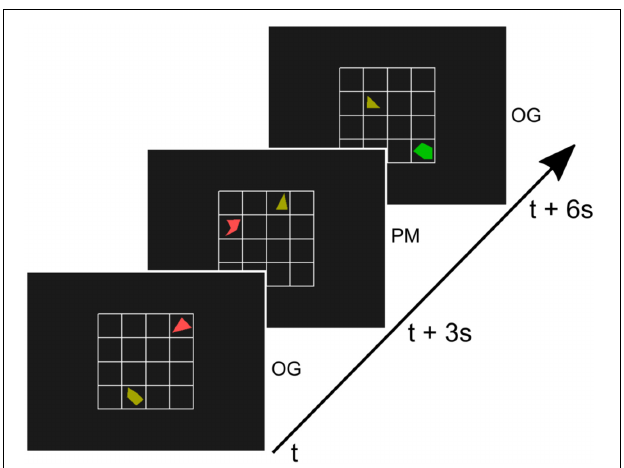
FIGURE 1 | Illustration of three trials of the paradigm. A 4 × 4 grid with a triangle and another random polygon was presented every 3 s for 500 ms. In most trials (90%), the ongoing trials (OG), subjects indicated by button-press whether the non-triangle-shape was positioned left or right to the triangle (adapted from Simons et al., 2006). If the two shapes were a chess knight’s move away from each other (second trial, middle) subjects had to press a different button. These prospective memory (PM) trials were rare